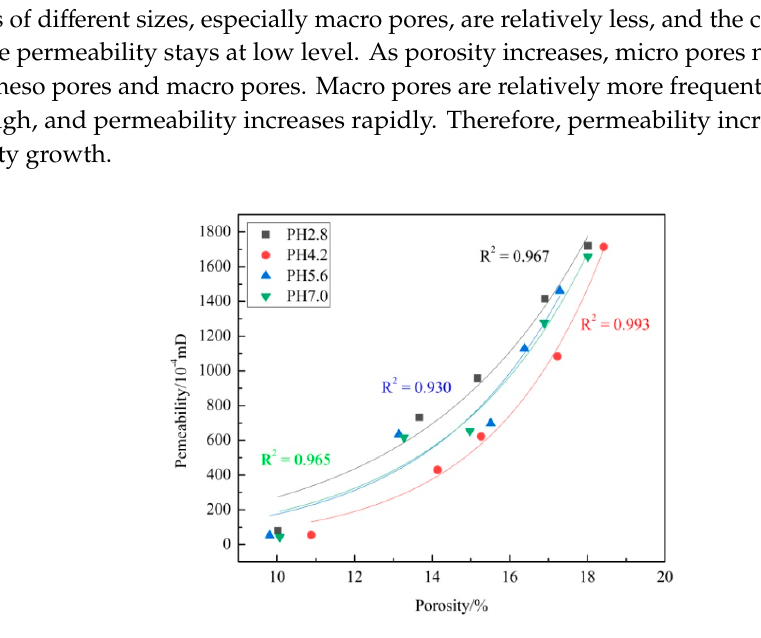
Figure 7. Correlation between porosity and permeability for sandstone immersed in different acidic